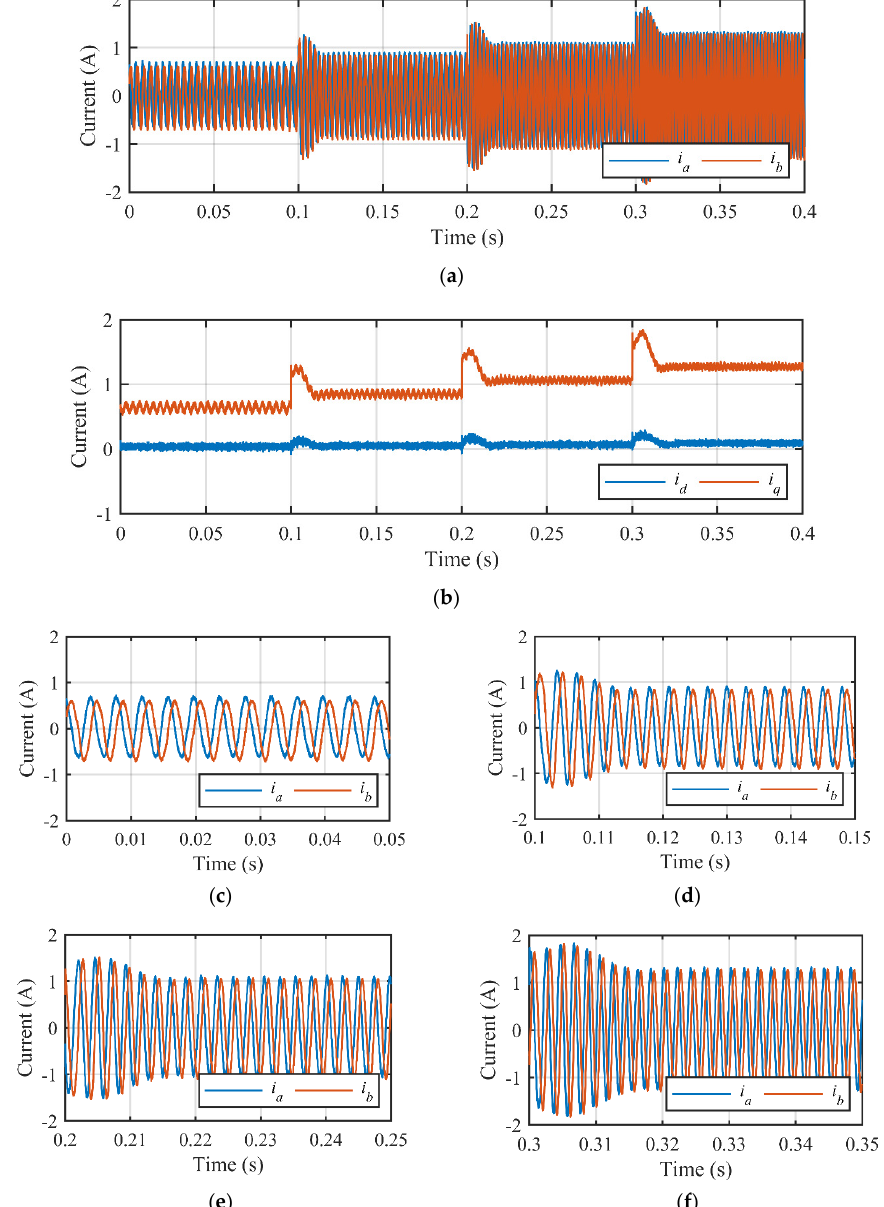
Figure 13. Experimental results of reference speed multi-step strategy, from 300 to 600 rpm, for ( a ) winding currents, ( b ) transformed currents in d-q coordinate, and the detail winding currents at ( c ) 300, ( d ) 400, ( e ) 500, and ( f ) 600 rpm.